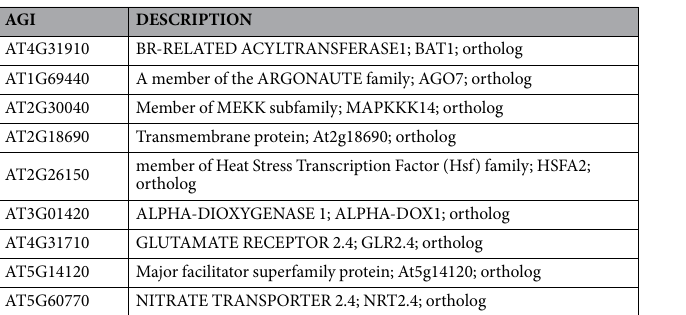
Table 5. Genes involved in nitrogen compound response and nitrate response clusters regulated by NRT1.1